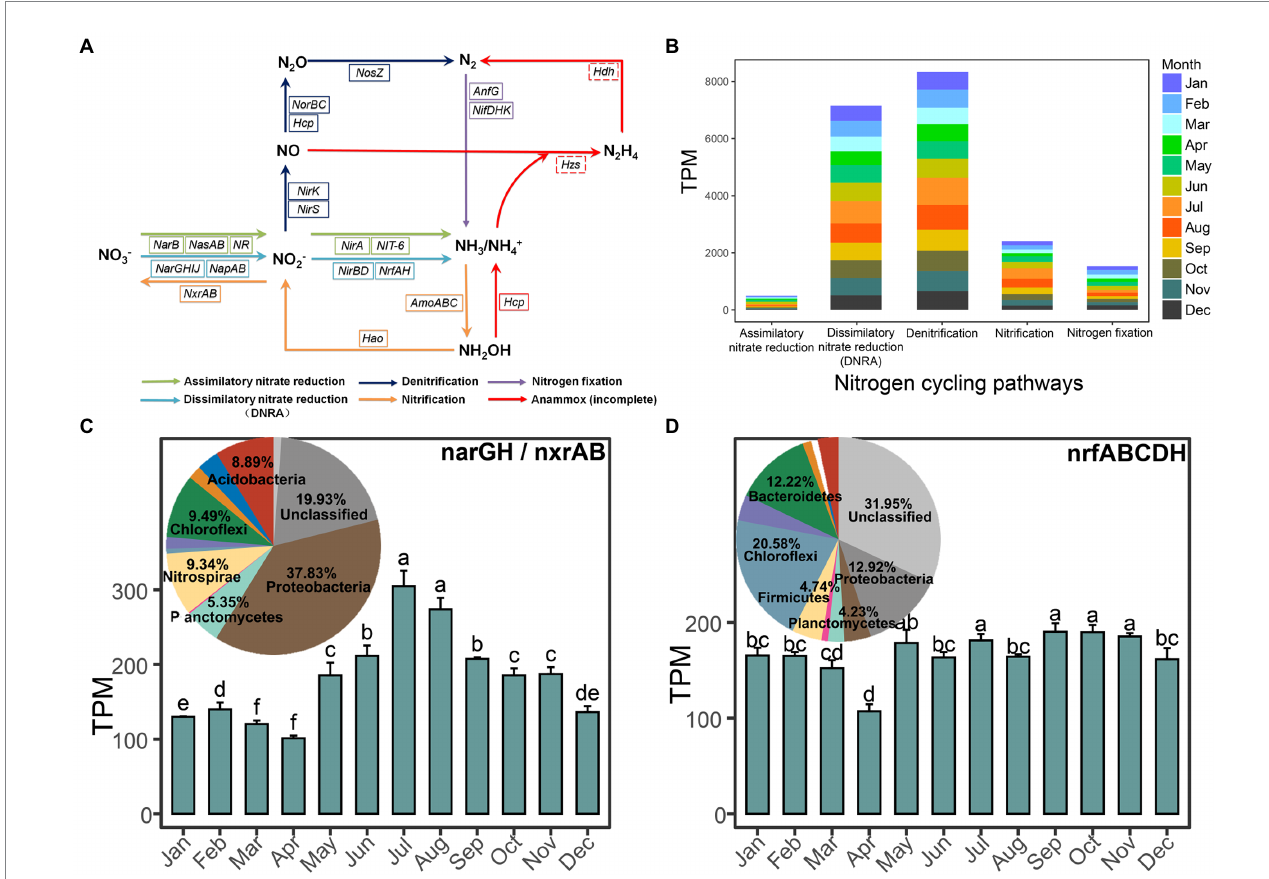
FIGURE 3 Overview of the key nitrogen-related genes and pathways in this anaerobic-activated sludge. (A) Key genes in the nitrogen cycling pathways. A solid box of genes represents the gene present and a dashed box of genes represents the gene absent in this EGSB system. (B) The stacked bar chart displays the proportions of the nitrogen cycling pathways represented by different months. Months are color-coded. (C,D) show the relative abundance of the most highly abundant genes narGH / nxrAB and nrfABCDH among each month, respectively, and their taxonomic